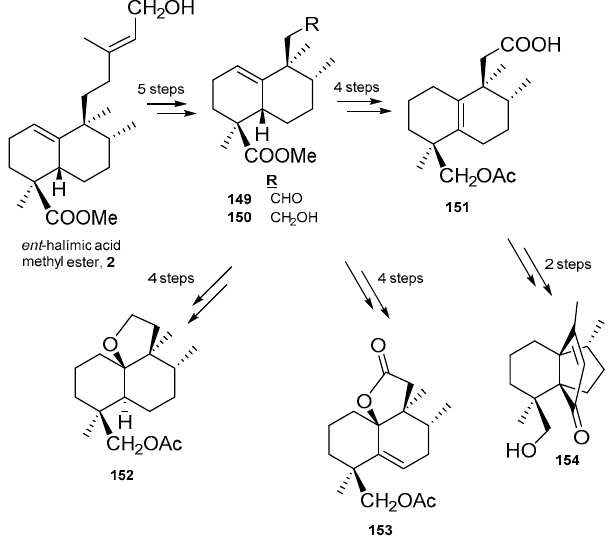
Scheme 9. Synthesis of propellane terpenoids from 2